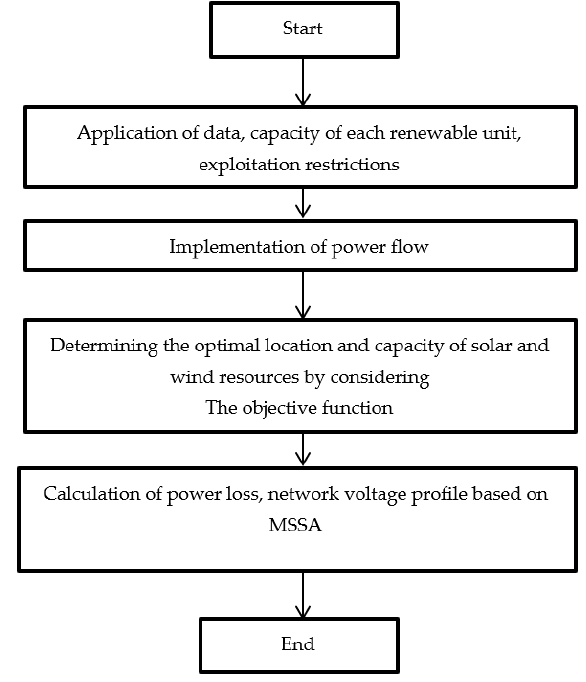
Figure 10. Overall solution procedure. Table 5. Optimal results of the algorithms for the first scenario.